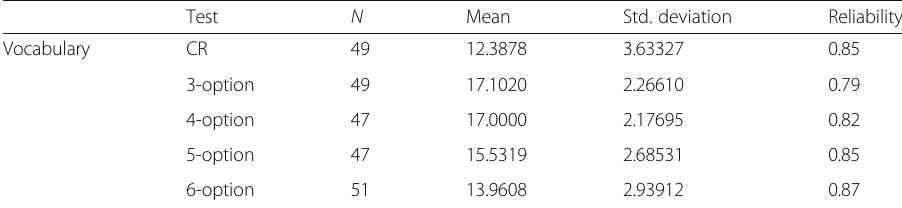
Table 3 Descriptive statistics for 3-, 4-, 5-, and 6-option MC and CR vocabulary tests Test